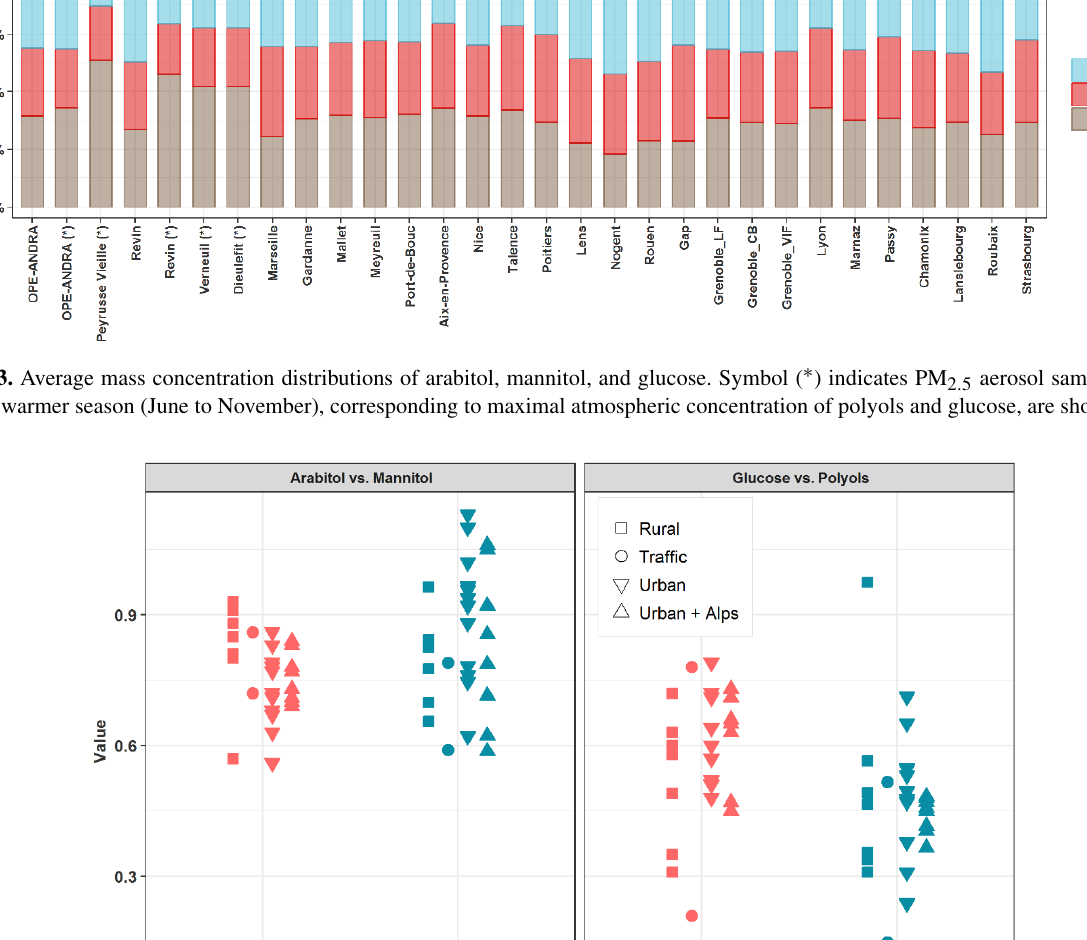
or coarse mode maxima depending upon sampling